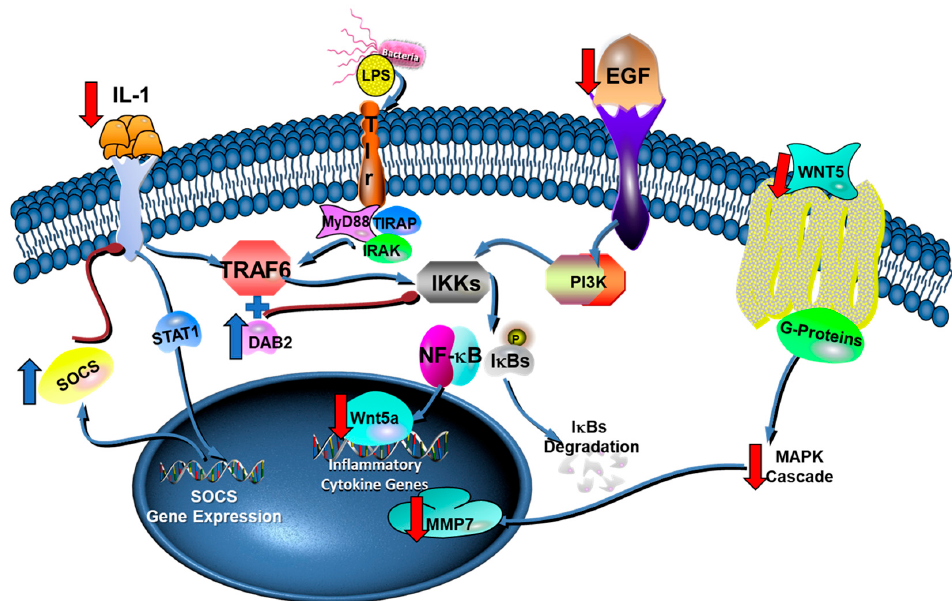
Figure 4. Molecular mechanisms of (3 S )-vestitol anti-inflammatory actions in LPS stimulated peri- toneal macrophages. “Red down arrow” indicates the decrease of genes transcription and/or pathway activation by (3 S )-vestitol treatment while an “blue up arrow” indicated the up-regulation of gene expression and/or pathway activation due to (3 S )-vestitol treatment. Adapted from Qiagen’s website [31] .